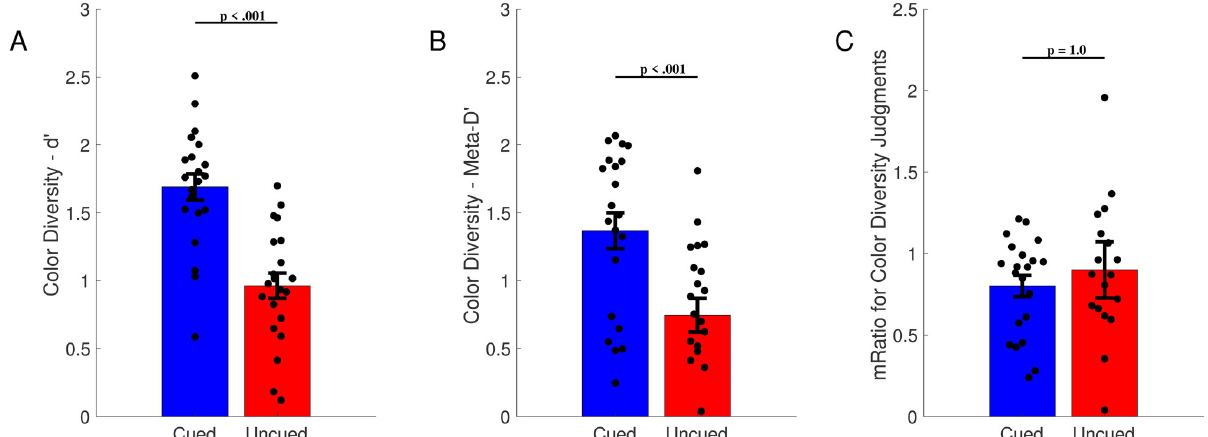
Fig 4. Measures of metacognition for color diversity judgments in Experiment 2. The mean of all subject averages is shown, with error bars showing SEM across subjects. (A) d’ for color diversity judgments. (B) Meta-d’ for color diversity judgments. This measure was significantly higher for cued compared to uncued regions of the circle. (C) The M-ratio. This measure of metacognitive efficiency was nearly identical for cued and uncued regions of the circle. Note that the high p-value is from Wilcoxon test.